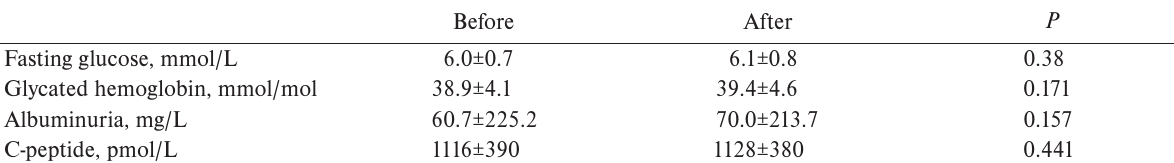
Table 3. Changes in glucose metabolism at 12 months in non-diabetes subgroup, n=26 (51%). Before After P